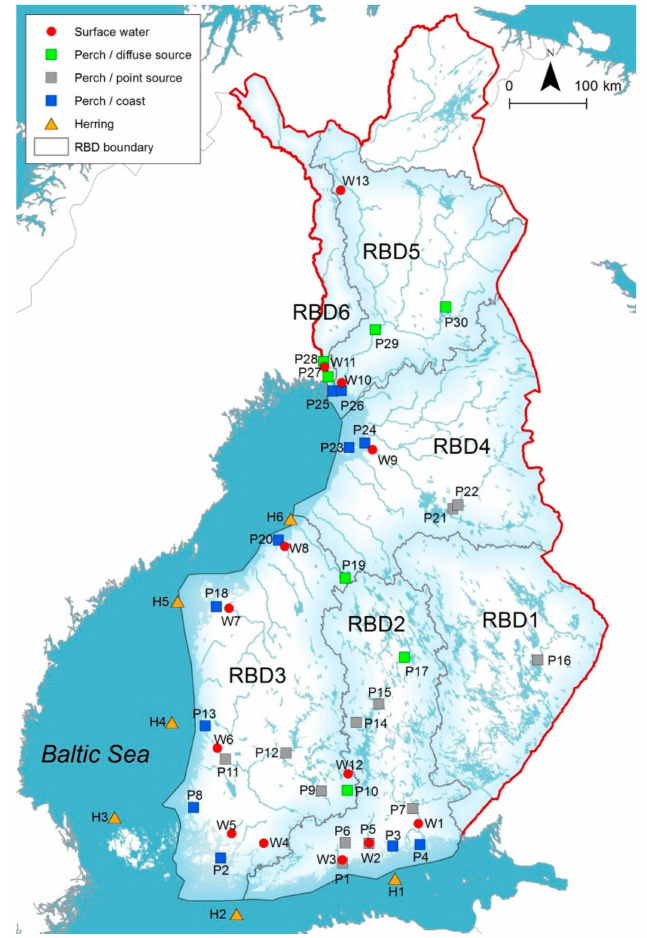
Figure 1. Sampling sites of surface waters and fish in river basin districts (RBDs) of Finland. Names of water bodies are presented in Table 2 (surface waters) and in the Table S1 (fish). (Background map by HELCOM) and Finnish Environment